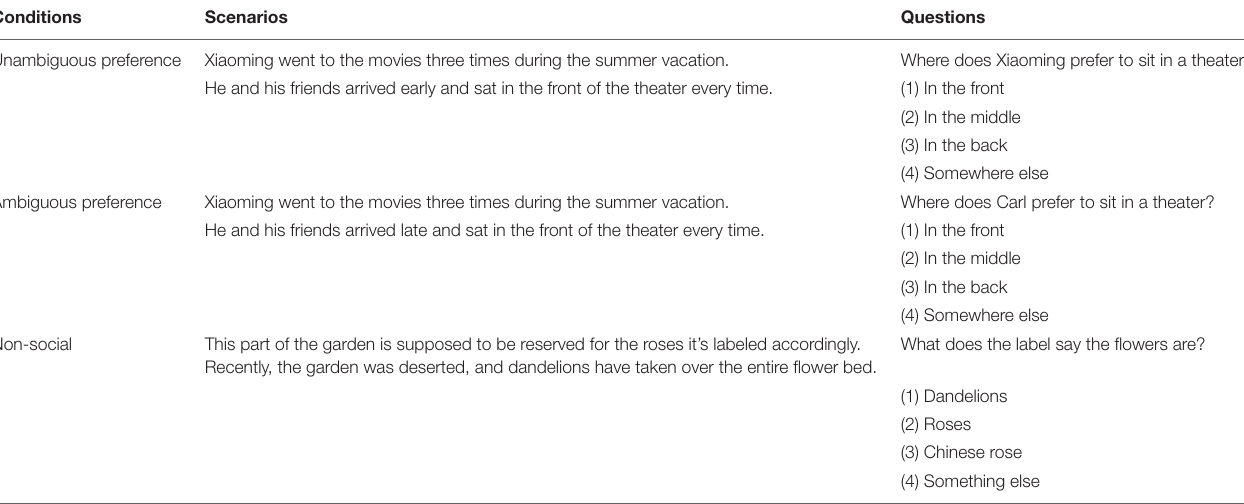
TABLE 1 | Example experimental item in each of the three conditions.